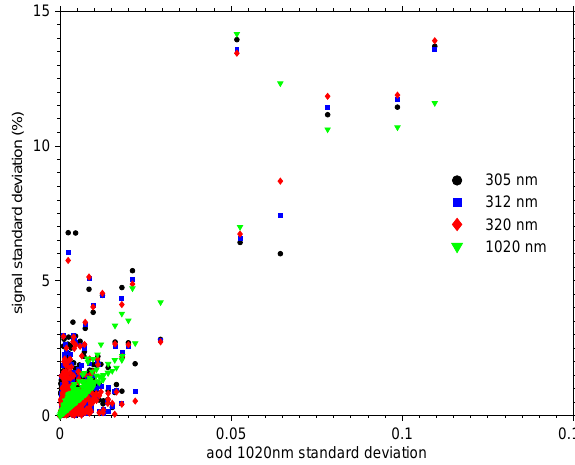
Fig. 2. Standard deviation of the Microtops II signals at 305, 312, 320, and 1020nm against the airmass. Data from all the field cam- paigns are shown.